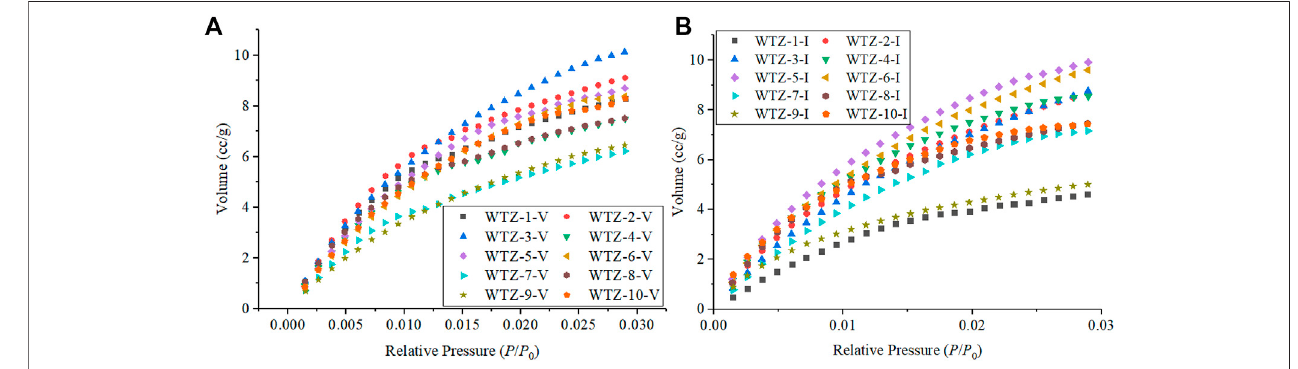
FIGURE 1 | CO 2 adsorption curves of vitrinite (A) and inertinite (B) .